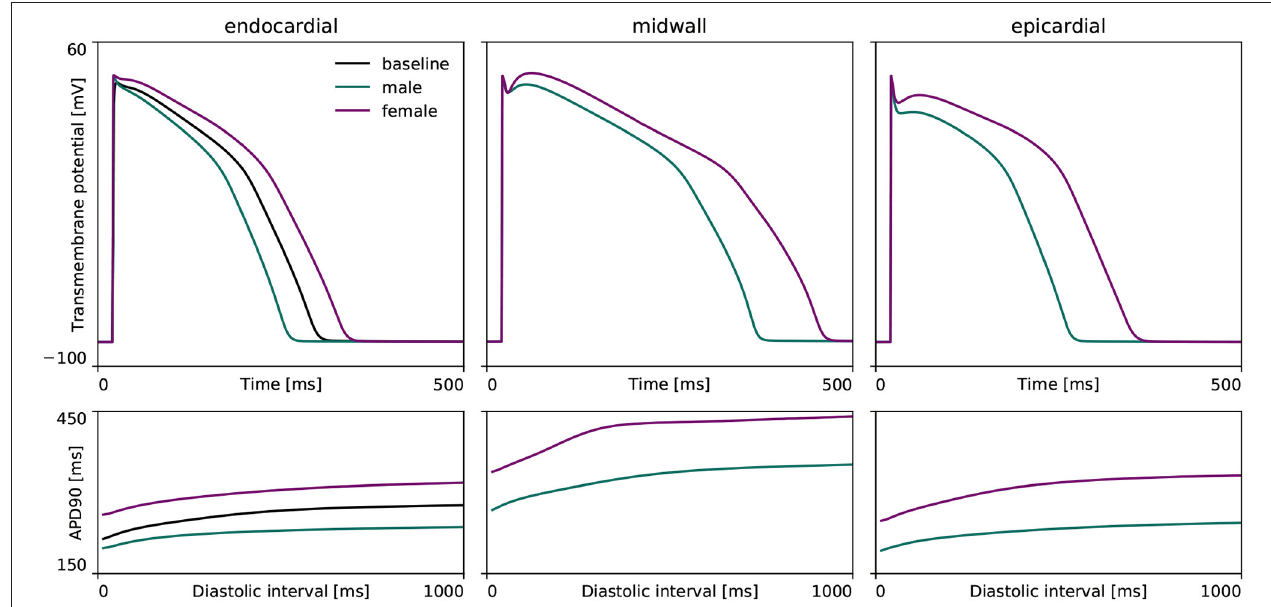
FIGURE 3 | Sex differences in transmural ventricular cardiomyocyte behavior . Sex-specific differences in endocardial, midwall and epicardial ventricular action potentials based on the experimentally quantified differences in ion channel activity. The green and purple lines represent the male and female steady state action potentials (Top) and action potential duration restitution curves (Bottom) for each transmural cell line. For the endocardial cell, the baseline steady-state action potential evolution and restitution curve of the calibrated and validated O’Hara-Rudy model for the 56% male / 44% female mixed-population is shown in black.